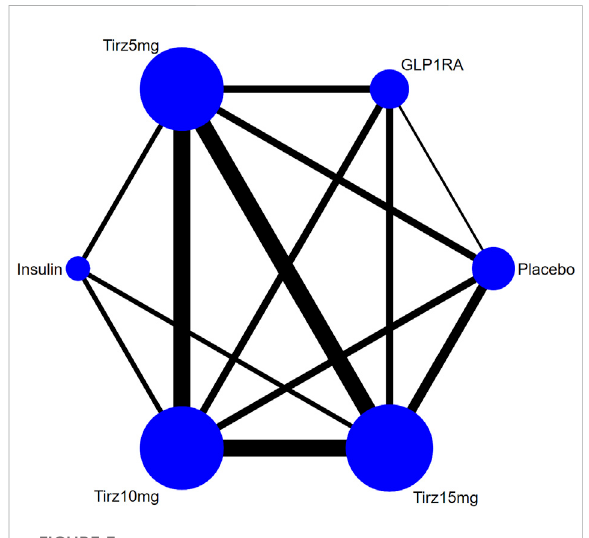
FIGURE 3 Network plot of effectiveness and safety outcomes. Note: The width of the lines in the network graph is proportional to the number of RCTs, and the node sizes correspond to the number of randomly assigned participants in the treatment comparisons. Tirz stands for tirzepatide. Semaglutide and dulaglutide are combined in group GLP1RA, and Insulin consists of degludec and glargine.